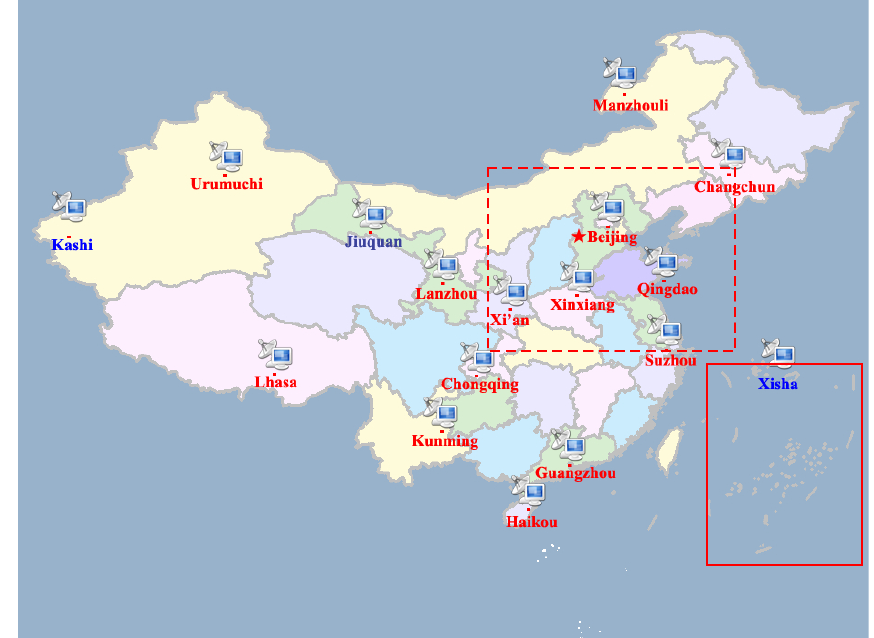
Fig. 1. The vertical sounding network over China. The established ionosondes are indicated in read, and the being established ionosondes are in